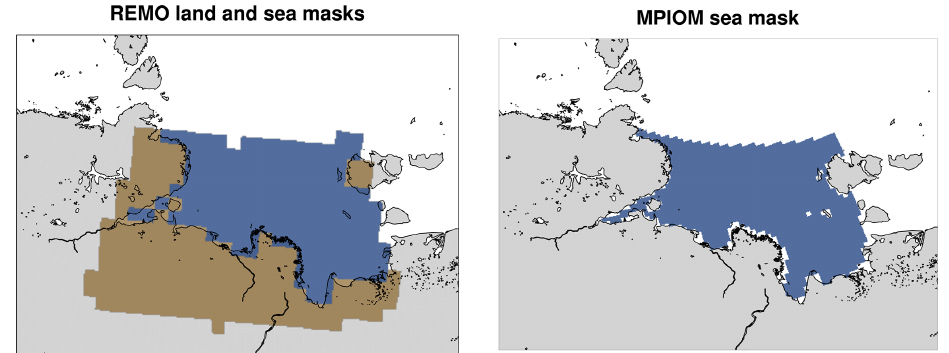
Figure 3. Colored areas show the model grid cells used in the analysis. Blue marks grid cells that are used for ocean variables, and brown signifies land grid cells used to produce one-dimensional time series. MPIOM output is only available over water. REMO output was reduced either over land, over water or over both jointly. Colored areas lie between 105–140 ◦ E and 70–77 ◦